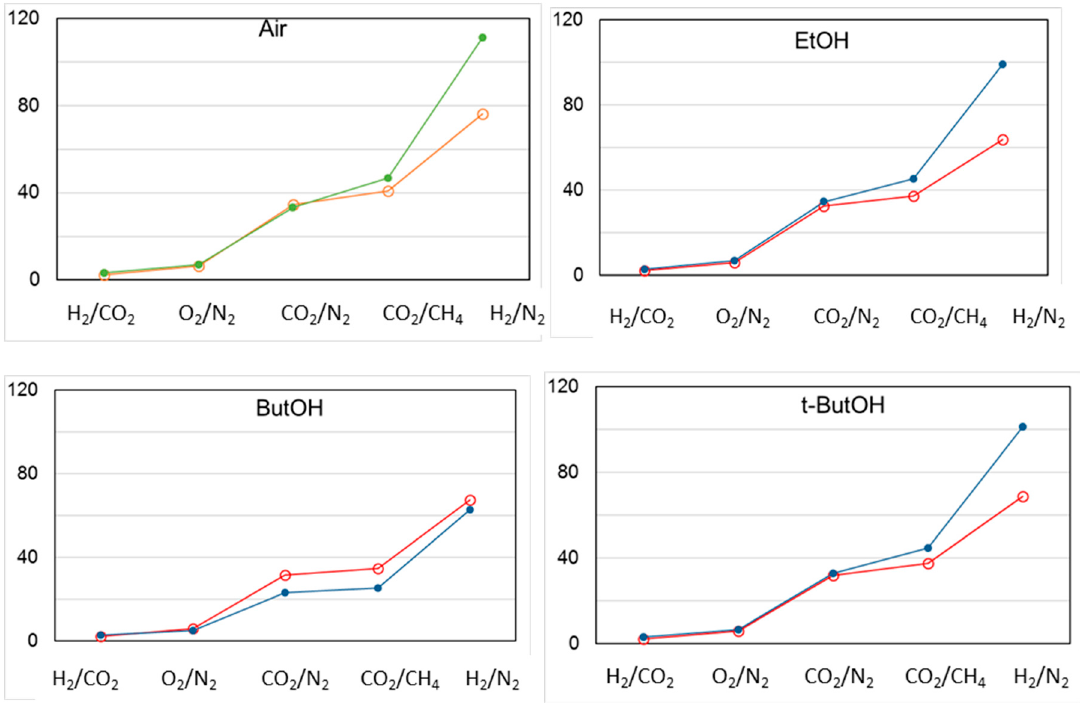
Figure 14. Change in permselectivity for different gas pairs in T1 membranes post-treated according to different protocols. Open circles: “as prepared” HFs; closed circles: aged HFs.